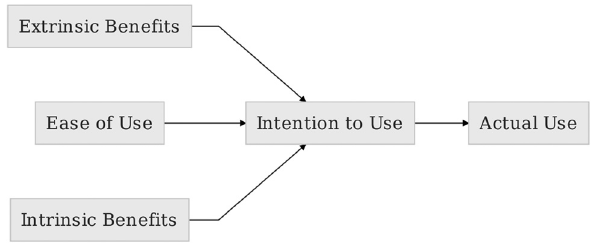
Figure 3: Technology acceptance